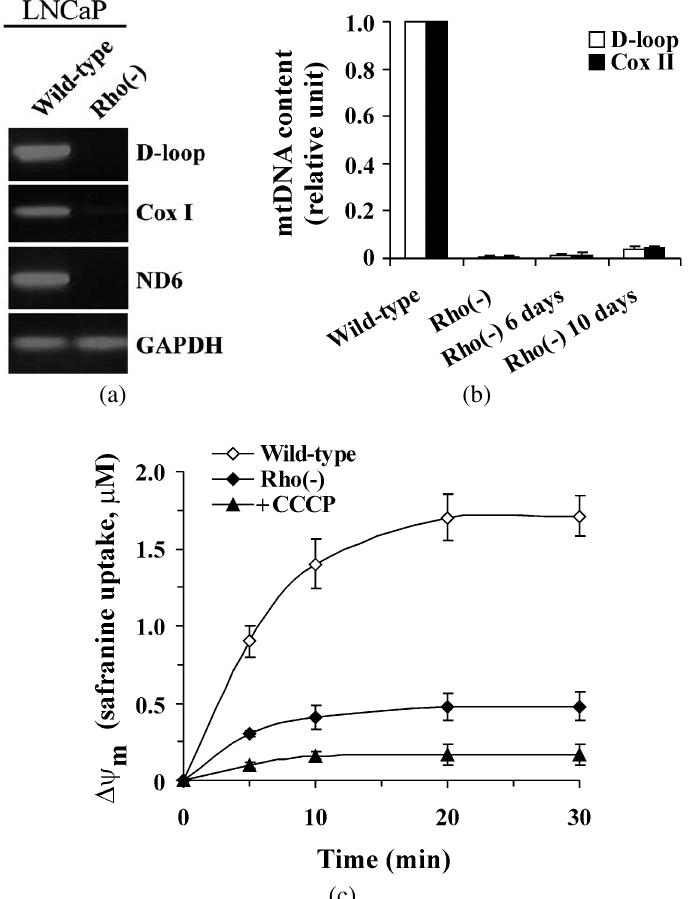
Fig. 4. Generation of Rho( − ) LNCaP cells. (a) LNCaP cells were treated with EtBr (100 ng/ml) and, after 20 days, the mtDNA content was analysed by PCR. Total DNA (10 ng/sample) was subjected to PCR using primers for D-loop, ND6 and Cox I. Signals of the nuclear-encoded gene GAPDH were used as control. PCR products were analysed by 1.5% agarose gel stained with EtBr. (b) The mtDNA content was quantitated by real-time PCR in wild-type and EtBr-treated LNCaP cells [Rho( − )] and in Rho( − ) LNCaP cells after 6 or 10 days in culture in absence of EtBr. Two mtDNA markers (D-loop and Cox II) and a nuclear DNA marker ( β -actin) were used. The relative amplification of mtDNA markers in Rho( − ) versus wild-type LNCaP cells was calculated upon normalization to the reference β -actin as described in Section 2. Values are the mean ± S.E. of three independent experiments. (c) To evaluate changes in ΔΨ m , 1 × 10 6 wild-type, Rho( − ) and CCCP-treated (25 µM for 12 h) LNCaP cells were incubated for 30 min at 37 ◦ C. At time zero, 20 µM safranine was added and the safranine concentration in the cells was measured following the absorbance decrease of the outer medium at 524 nm. Data are reported as mean ± S.E. of three different